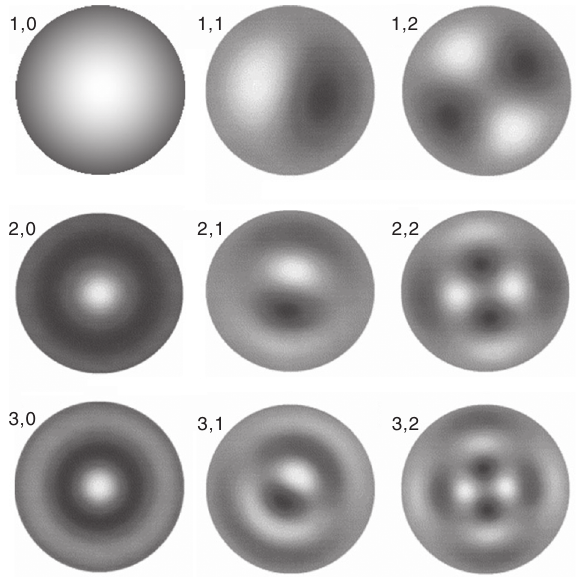
Figure 1. Spatial representation of Fourier-Bessel modes. The pairs of numbers indicate the Bessel root and order,